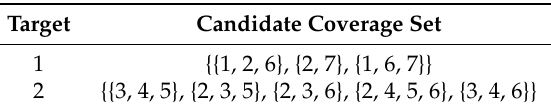
Table 1. Candidate coverage